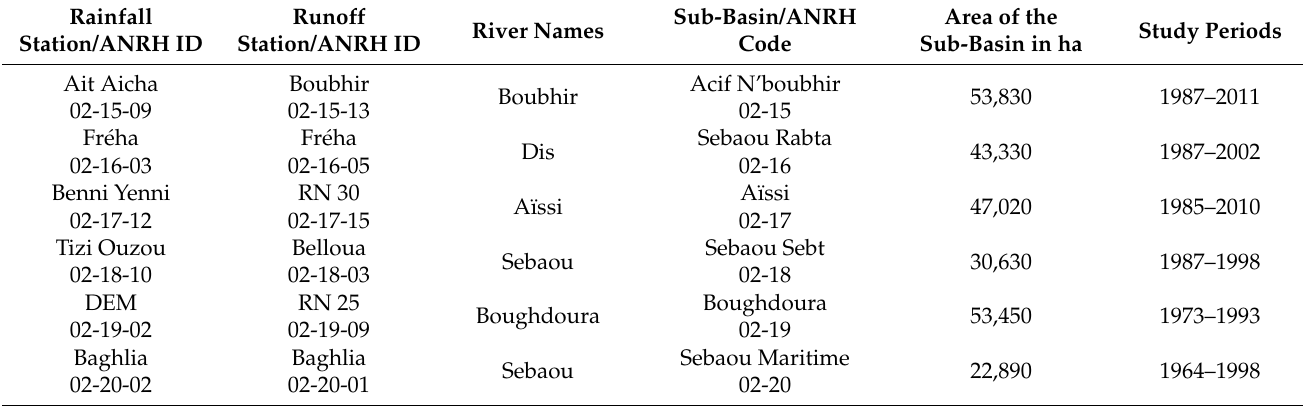
Table 1. Rainfall and runoff stations, and sub-basins studied in the cross analysis.